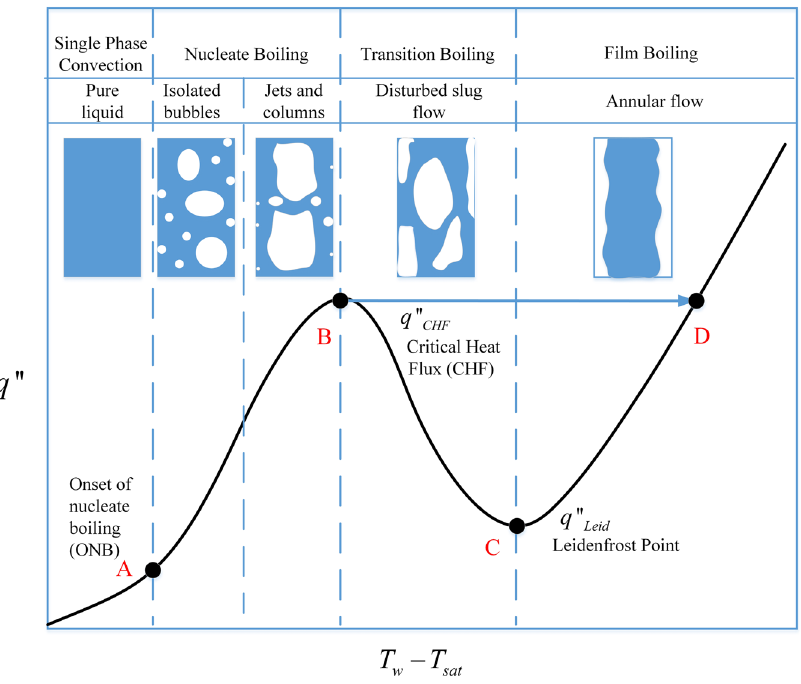
Figure 1. A typical boiling